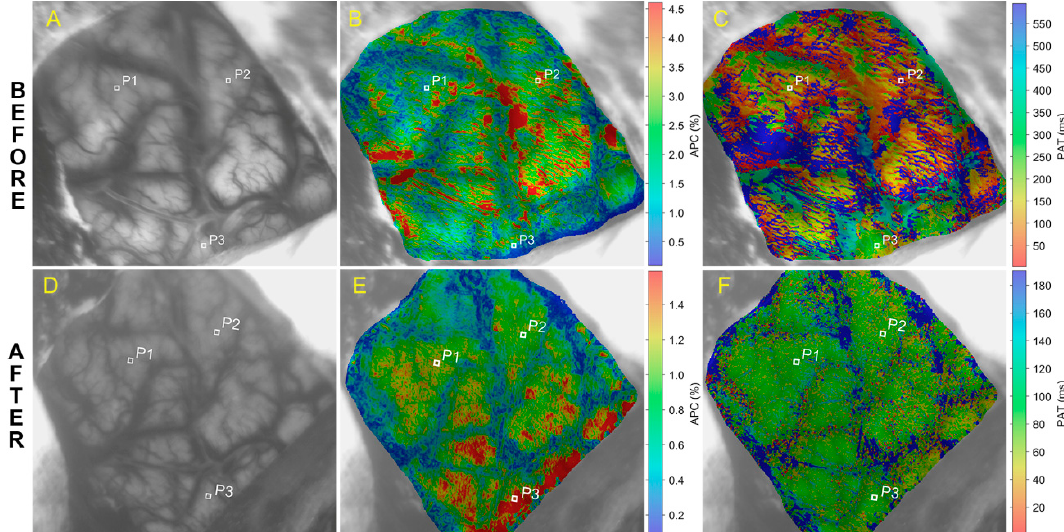
Figure 3. Parameters of pulsatile blood flow in an open brain cortex before (upper row) and after (lower row) anastomosis application: The maps of the APC and PAT in panels ( B ), ( C ) and ( E ), ( F ) are overlaid with still images shown in photographs ( A ) and ( D ) of the cortex before and after surgery, respectively. The color scales on the right side of images ( B ) and ( E ) show APC in percent, whereas that of images ( C ) and ( F ) is PAT in milliseconds. Small white scares with markers P1, P2, and P3 indicate the position of three representative ROIs with size of 7 × 7 pixels.